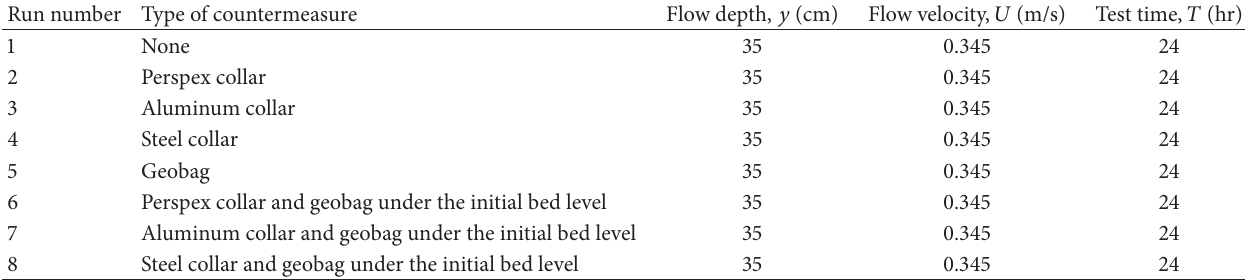
Table 1: Summary of experiments.